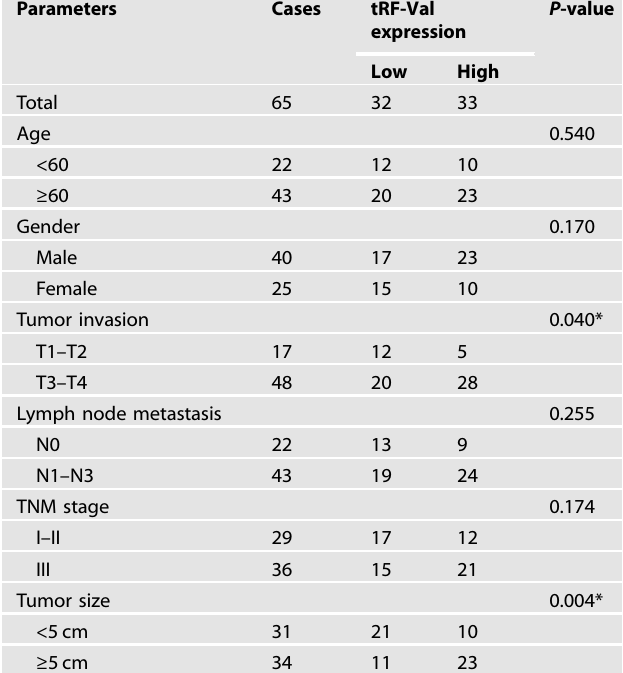
Table 1. Correlation between tRF-Val expression and clinicopathological characteristics in 65 GC patients.